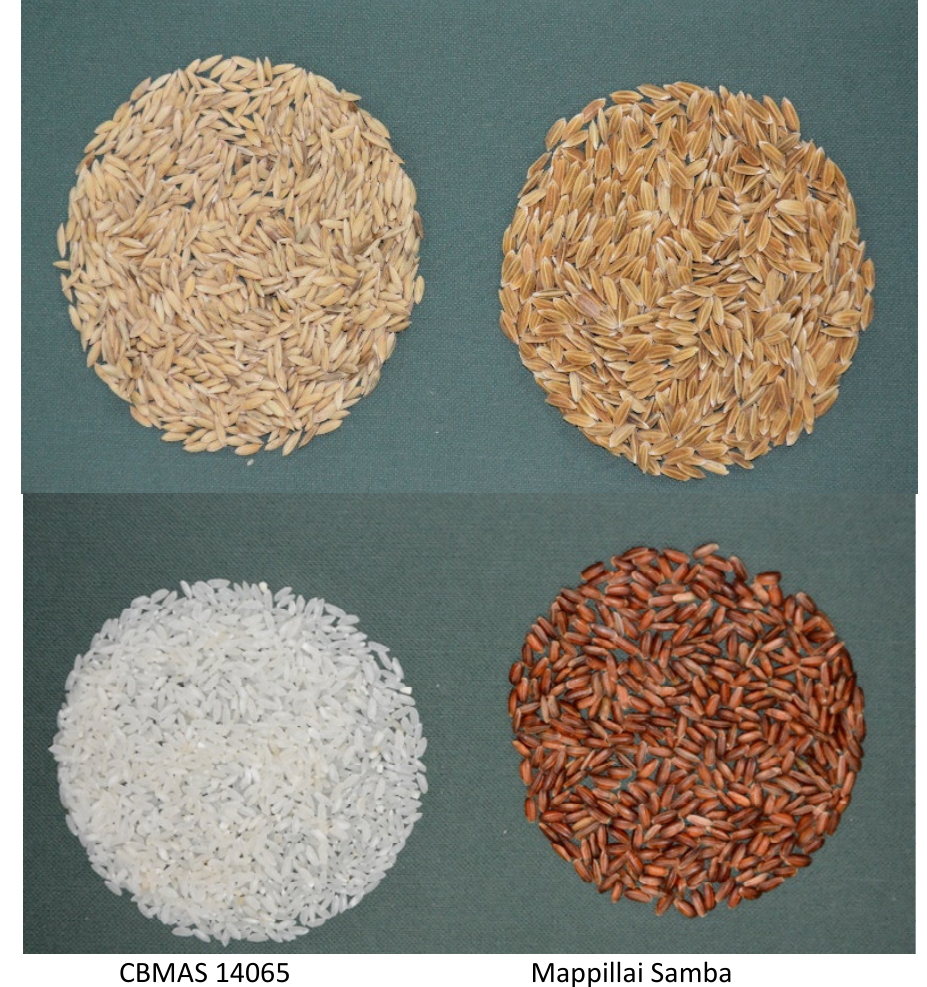
Figure 1. Grain characteristics of the rice genotypes CBMAS 14065 and Mappillai Samba.